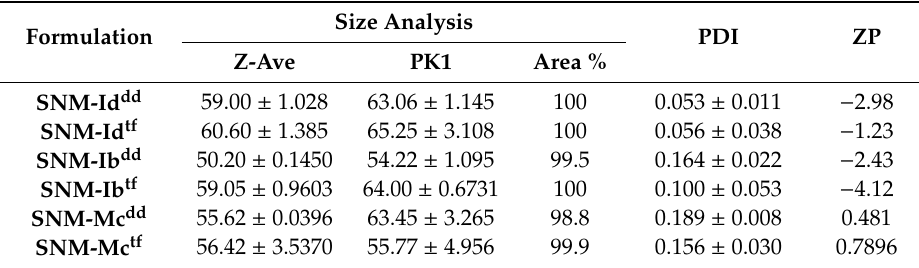
Table 2. Size analysis (Z-Ave), polydispersity index (PDI) and Zeta potential (ZP) values of drug-loaded Soluplus ® nanomicelles produced by the direct dissolution method (dd) or by thin film hydration (tf).